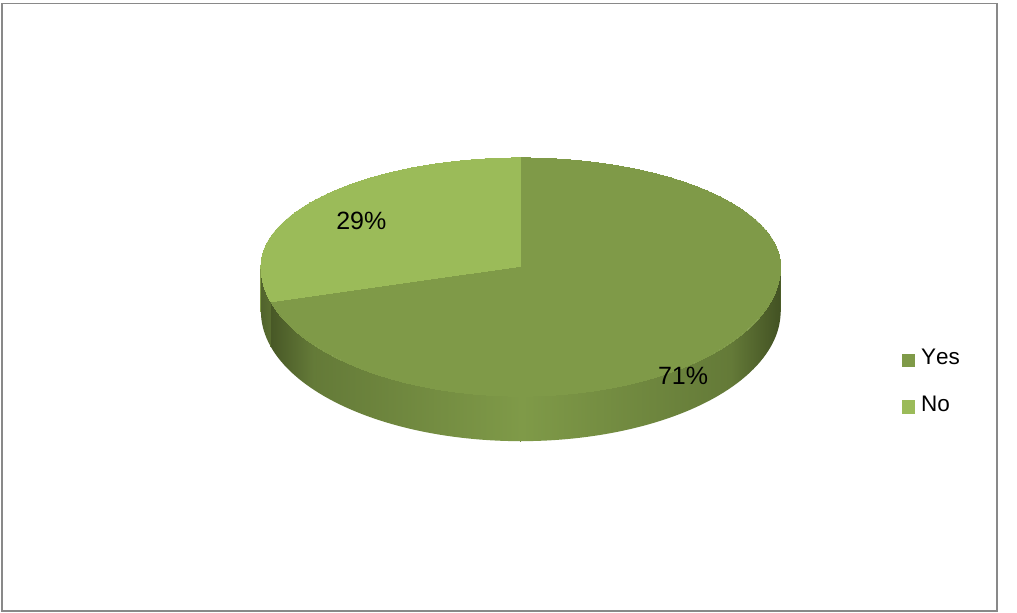
ViolenceFigure 6: Heroism often Involves